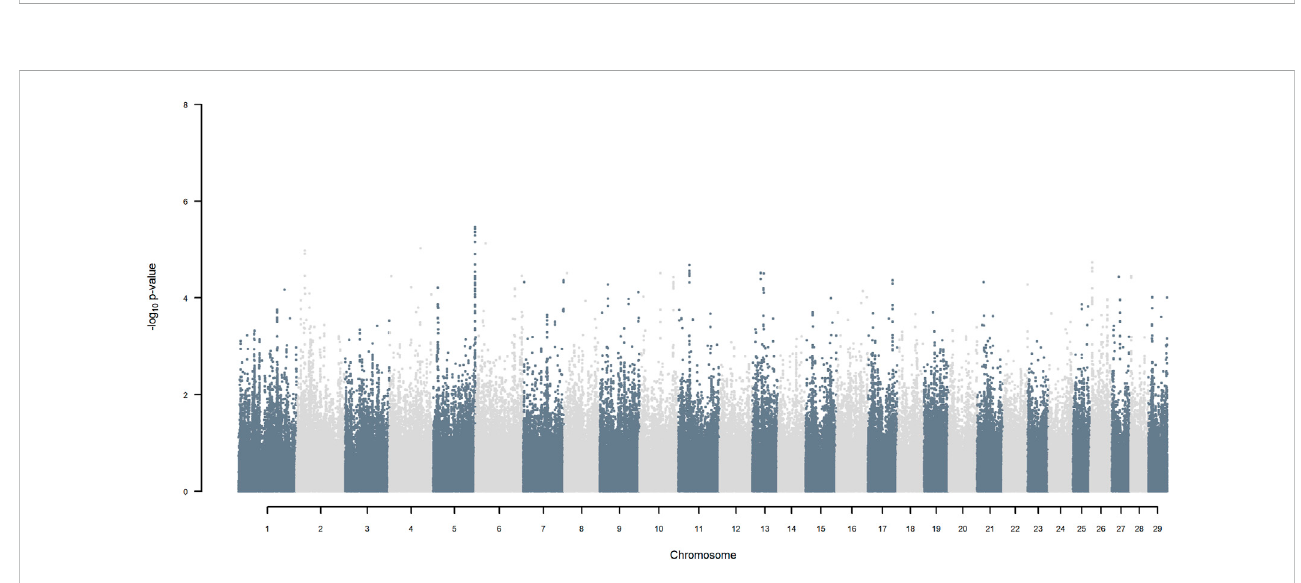
FIGURE 10 Manhattan plot of GWAS (Models 3 & 4) for SNP allele of Jersey origin using SNP alleles of all origins that had a MAF > 1%.